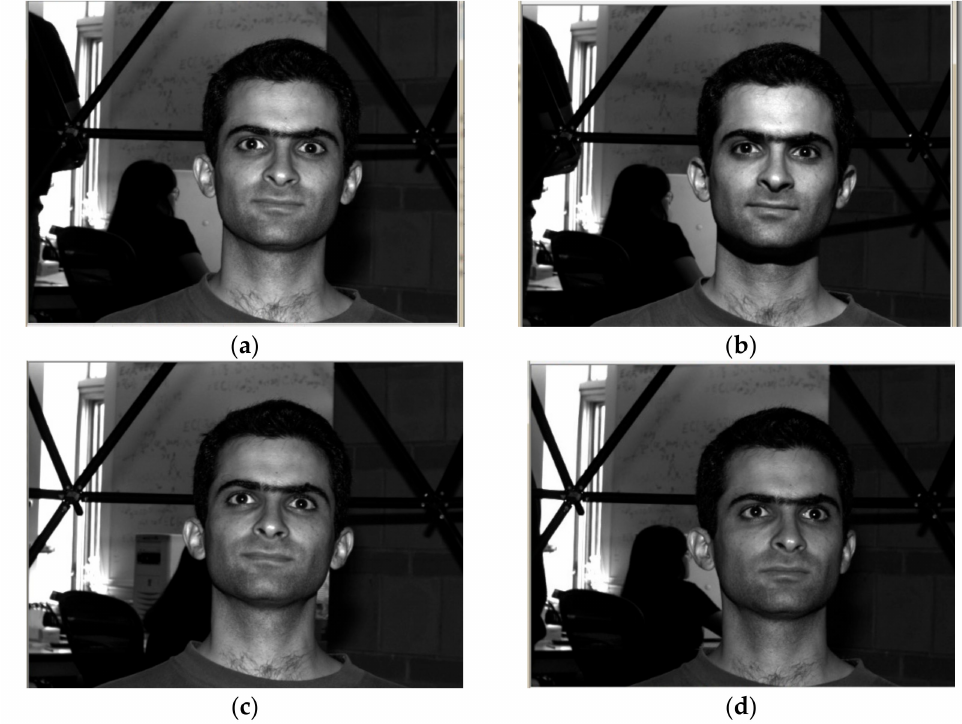
Figure 6. Image results using Extended Yale B database, ( a ) illumination image-1, ( b ) illumination image-2, ( c ) pos image-1, ( d ) pos